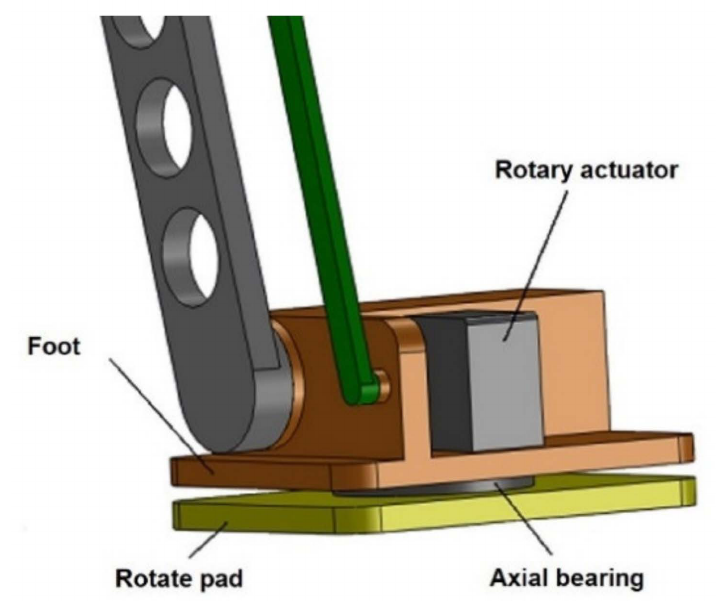
Figure 2. The concept of a rotating foot to change the walking